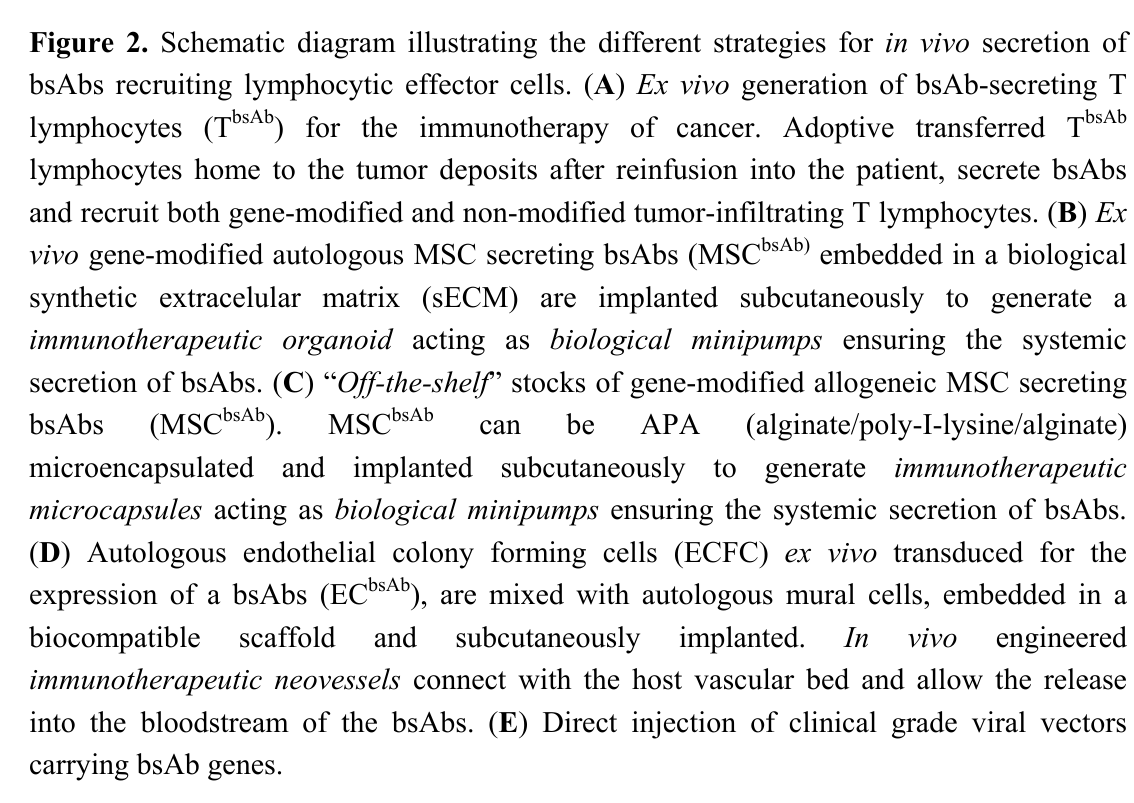
Figure 2. Schematic diagram illustrating the different strategies for in vivo secretion of bsAbs recruiting lymphocytic effector cells. ( A ) Ex vivo generation of bsAb-secreting T lymphocytes (T bsAb ) for the immunotherapy of cancer. Adoptive transferred T